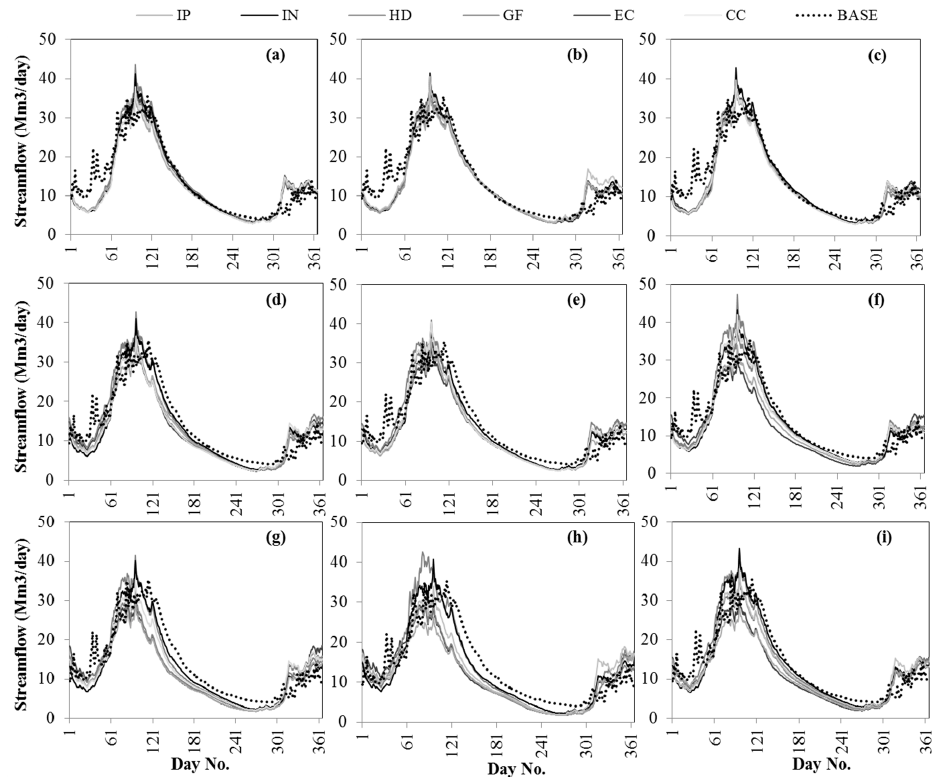
Figure 8. The annual pattern of observed streamflow (dotted graph) and future projected streamflows of SUB- 4. ( a ): A1B-2020s; ( b ): A2-2020s; ( c ): B1-2020s; ( d ): A1B-2050s; ( e ): A2-2050s; ( f ): B1-2050s; ( g ): A1B-2080s; ( h ): A2-2080s; ( i ): B1-2080s. Table 4. The percentage of the variation of the discharge from sub-basins 1 to 4 under the climate change conditions projected by the six GCMs and three SRES scenarios for the 2020s, 2050s, and 2080s time horizons compared to the base period.